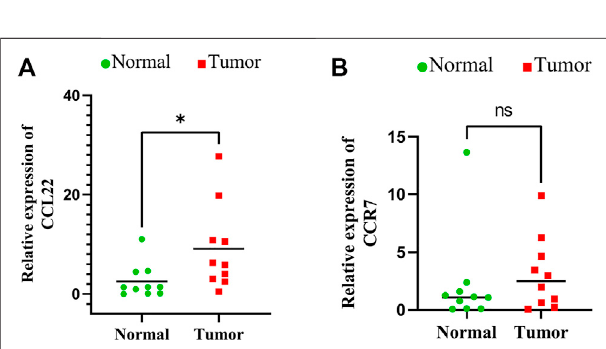
FIGURE 9 | Expressions of signature genes CCL22 and IL10 were upregulatedinheadandnecksquamouscellcarcinoma. (A) qPCRanalysisof CCL22 mRNA levels in tumor and adjacent normal tissues. (B) qPCR analysis of IL10 mRNA levels in tumor and adjacent normal